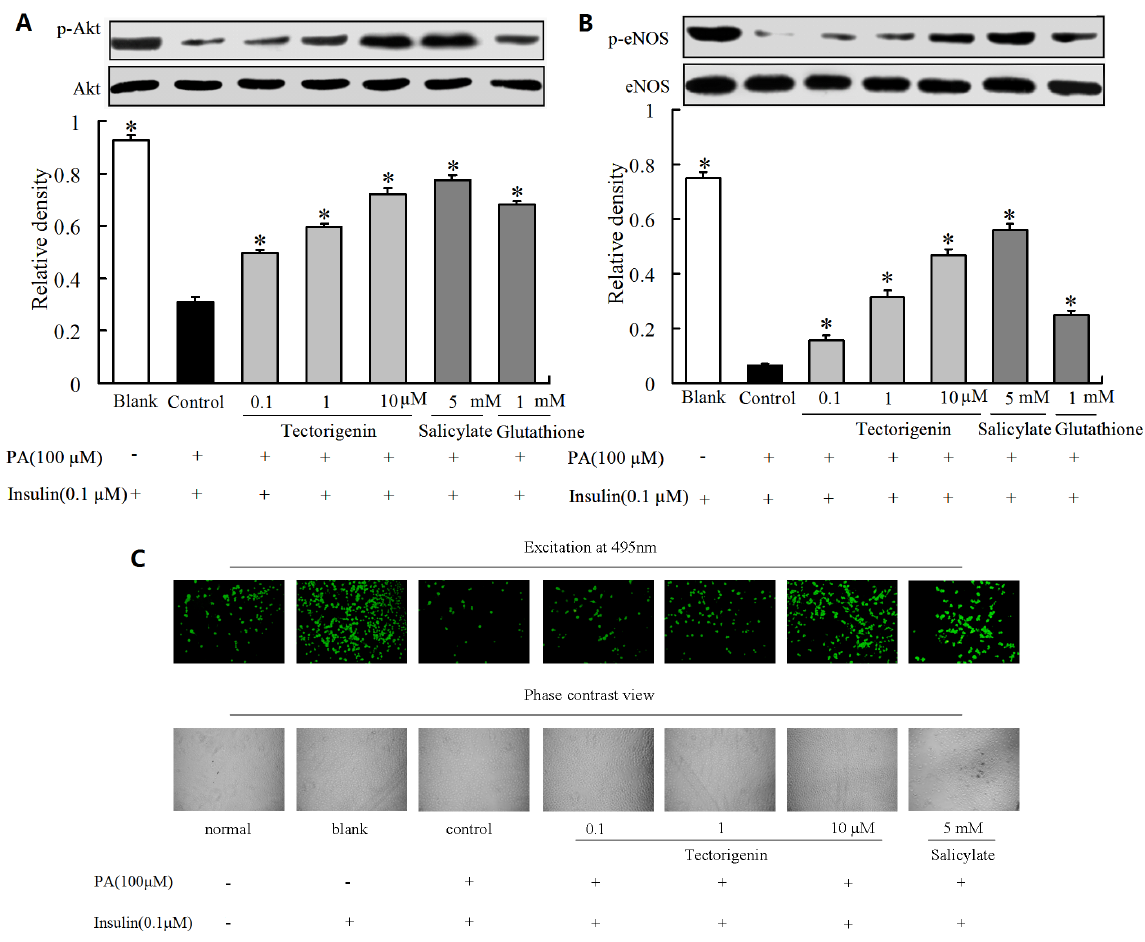
Figure 6. The effects of tectorigenin on insulin-mediated Akt and eNOS phosphorylation and NO production in HUVECs. (A–B): HUVECs were pretreated with tectorigenin, salicylate or GSH for 30 min, and then co-incubated with 100 m M PA for 30 min. After addition of insulin (100 nM) for 20 min, p-Akt (A) and p-eNOS (B) was determined by Western blot. The results were presented as mean 6 SD of three independent experiments. * p , 0.05 vs control group. (C) HUVECs were pretreated with tectorigenin or salicylate for 30 min, then incubated with 100 m M PA for another 30 min, followed by insulin (100 nM) stimulation for 5 min. Intracellular NO production was tested with fluorescence microscopy.